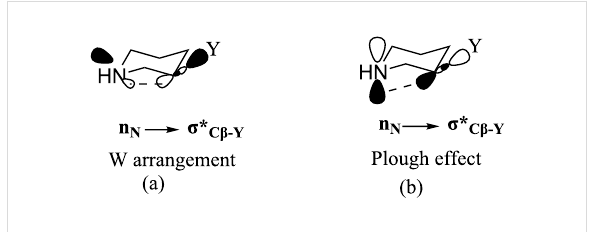
Figure 3: Schematic representation of possible homoanomeric interac- tions in six-membered saturated heterocycles. (a) Homohyperconjuga- tion through the W arrangement, (b) homohyperconjugation through the Plough